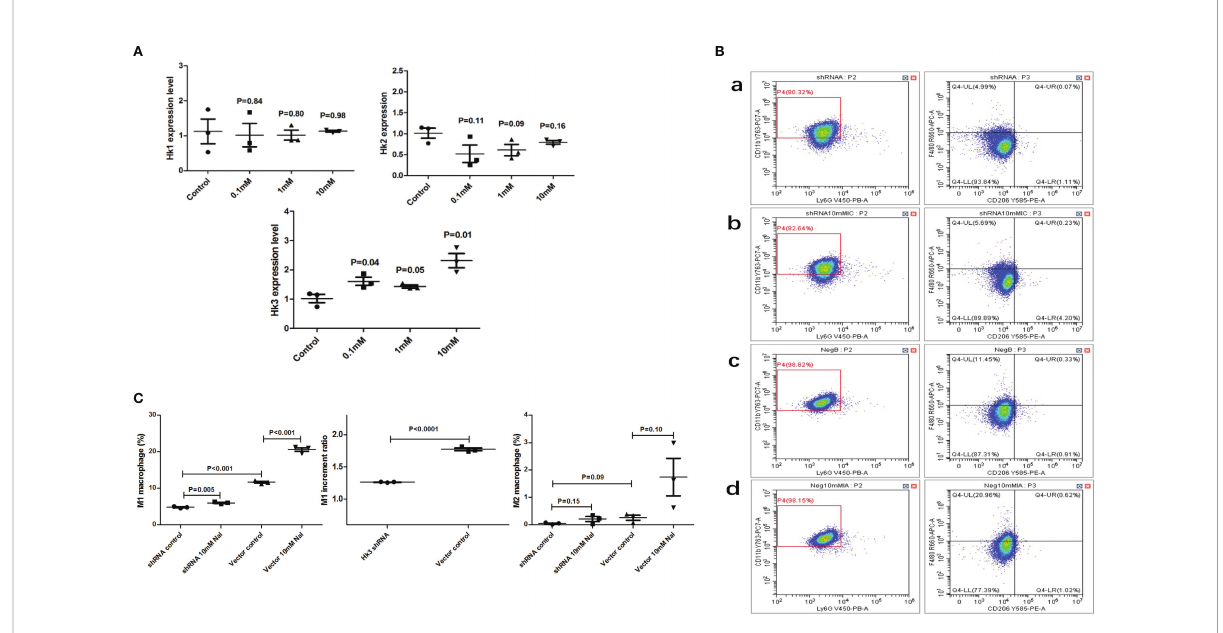
FIGURE 7 High iodine can promote HK3 expression in RAW264.7 cells. (A) mRNA expression of HK1, HK2 and HK3 after high iodine stimulation; (B) Flow cytometry of macrophage proportions. a: HK3 shRNA lentivirus-control group; b: HK3 shRNA lentivirus-high iodine stimulation group; c: negative lentivirus-control group; d: negative lentivirus high-iodine stimulation group; (C) Statistics of macrophage